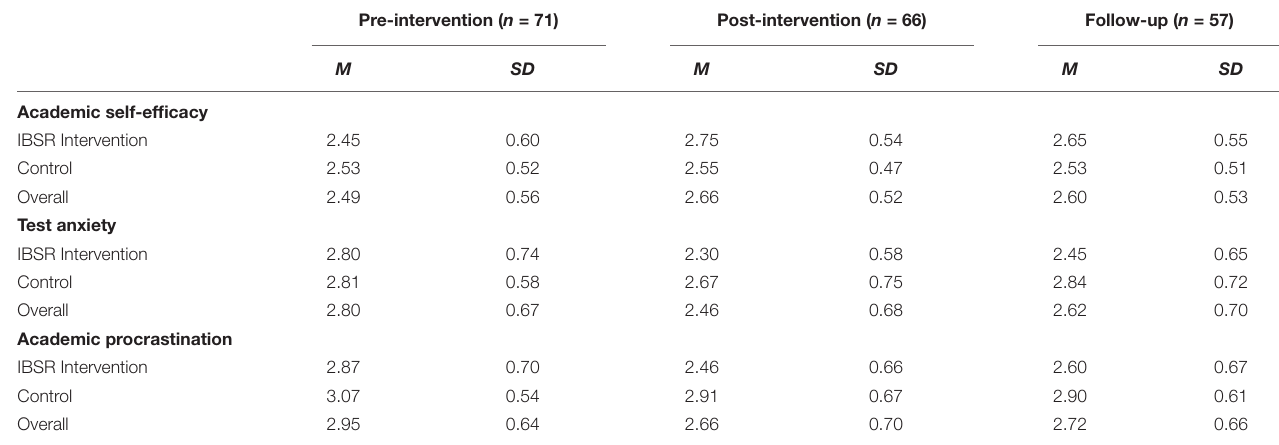
TABLE 3 | Means and standard deviations for academic self-efficacy, test anxiety, and academic procrastination for IBSR intervention and control